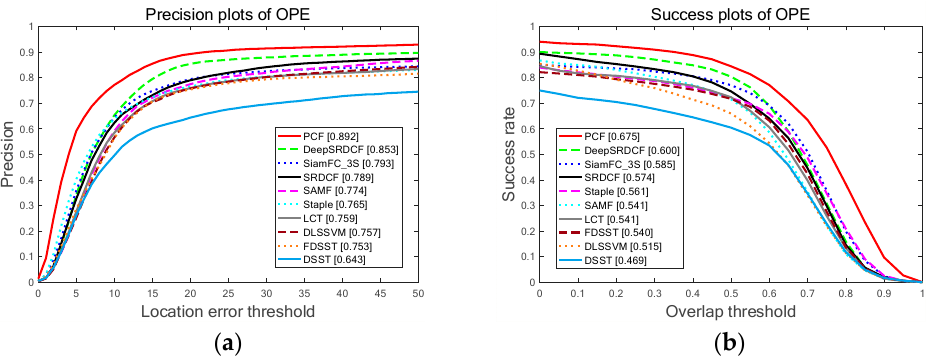
Figure 8. The comparing results for the top ten trackers with the whole 50 sequences on OTB-2013 benchmark: ( a ) The PP of the OPE on all sequences; ( b ) The SP of the OPE on all sequences. Table 4. The PP of the OPE on OTB-2013 benchmark for the top ten trackers on eleven different attributes (%): SV, IV, OPR, OCC, BC, DEF, MB, FM, IPR, OV, LR. The last column is the average precision (AP) of LET at 20 pixels. The top three ranks are marked in red , cyan , and blue , respectively. Trackers